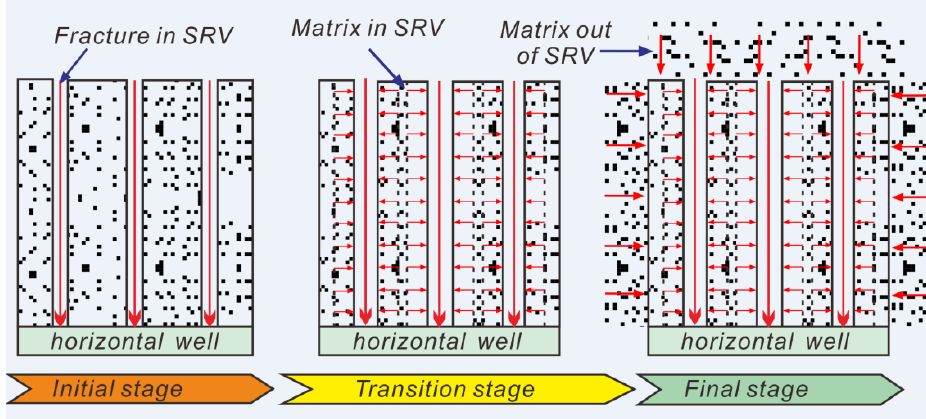
Figure 1. Schematics for each production period of the fractured horizontal well.